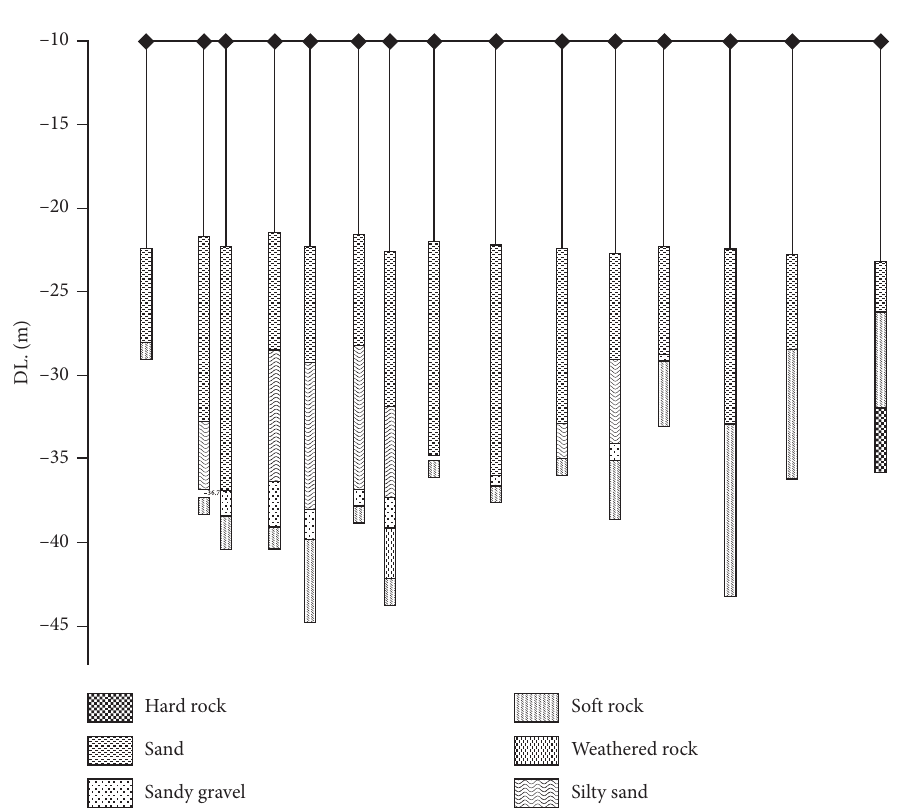
Figure 2: Boring results at the west breakwater in Jeju Outer